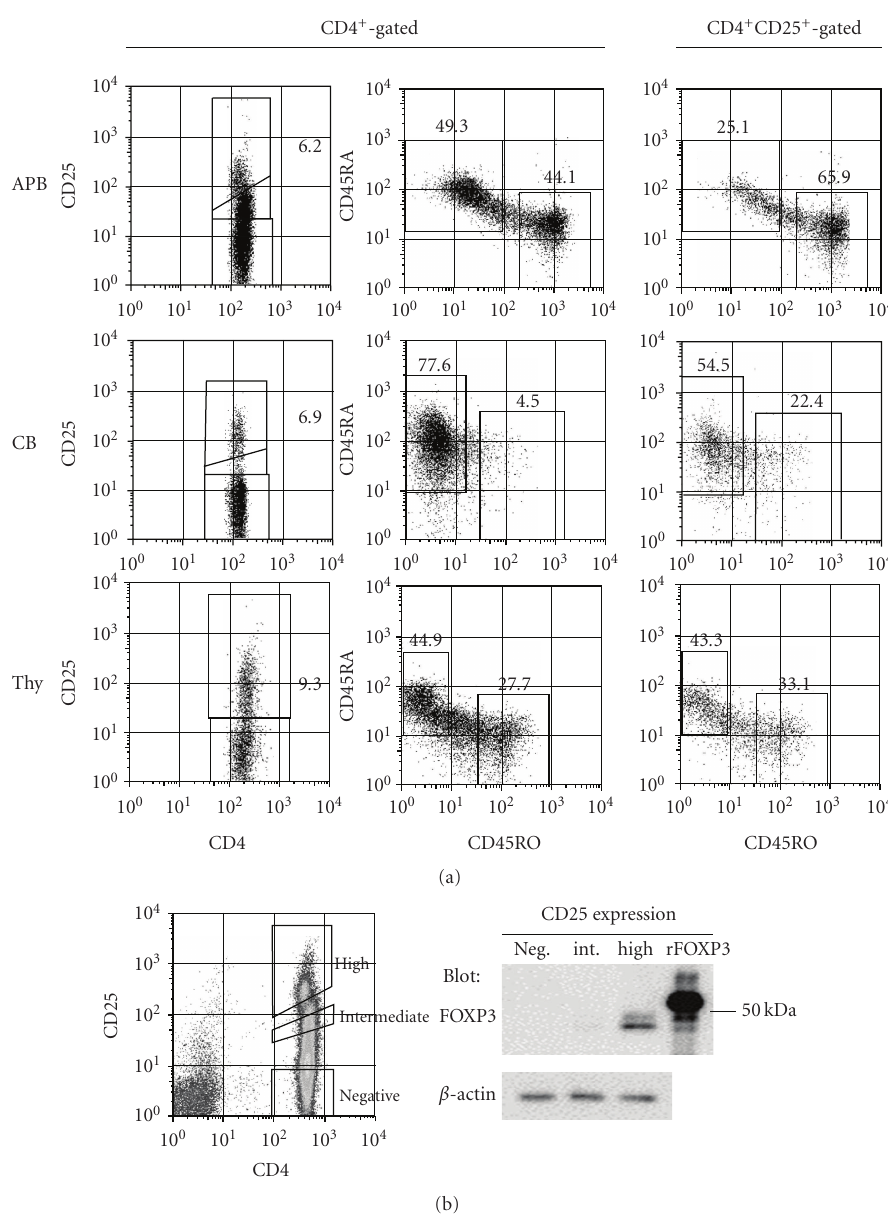
Figure 1: Predominance of CD45RA + type CD25 + CD4 + T cells in CB, and existence of CD45RA + and CD45RO + type CD25 + CD4 + T cells in APB and Thy. (a) Mononuclear cells or thymocytes were multistained with anti-CD3, anti-CD4, anti-CD8, anti-CD25, anti-CD45RA, anti-CD45RO, anti-CD62L mAbs, and PI (Table 1). The profiles were gated for PI − CD3 + CD8 − CD4 + cells (left and middle columns) or CD3 + CD8 − CD4 + CD25 + cells (right column), and expression of CD45RA versus CD45RO was illustrated. Data are representative of 3 di ff erent donors. (b) APB CD4 + T cells were stained with anti-CD4 and anti-CD25 mAbs. On the basis of CD4 and CD25 expression, CD25 high CD4 + cells, CD25 intermediate CD4 + cells, and CD25 negative CD4 + cells were sorted. Each cell population was lysed and immunoblotted with anti-FOXP3 or anti- β -actin Ab. FOXP3 in human PBMC was detected at a lower position than the recombinant human FOXP3 fusion protein used as positive control, since the recombinant human FOXP3 fusion protein contains approximately 4kDa of additional peptides such as the 6xHis tag, Xpress epitope tag, and enterokinase recognition site, as described in Section 2 .